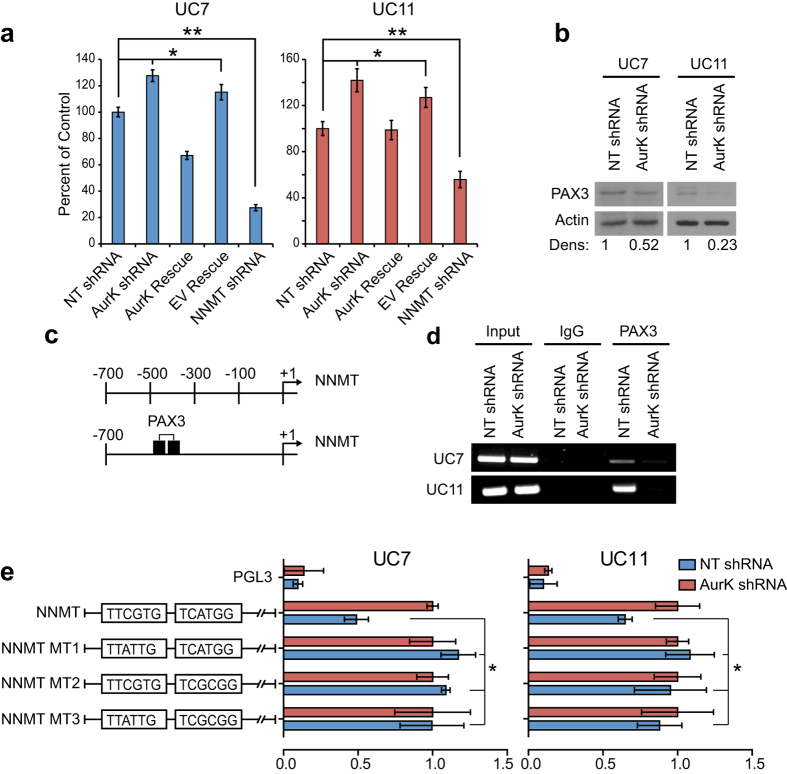
Transcriptional regulation of NNMT expression.(a) An NNMT activity assay was performed on UC7 and UC11 cell lines. The activity of NNMT normalized to actin correlated with its expression levels (*P < 0.05, **P < 0.01). (b) Western blotting revealed that expression levels of PAX3 decrease upon silencing of AURKA. Full length blots are shown in Supplementary Fig. S7. (c) Schematic presentation of the NNMT promoter. Two PAX3 binding sites are located within 500 bp upstream of the NNMT transcription start site. (d) Chromatin immunoprecipitation indicates that PAX3 binds to the NNMT promoter and represses its expression in both UC7 (top) and UC11 (bottom) cell lines. Full length gels are shown in Supplementary Fig. S7. (e) Luciferase based promoter analysis of the NNMT promoter with mutations in either of the PAX3 binding sites leads to an increase in luciferase expression in the non-targeted (NT) cells to similar levels as the AURKA KO cells. Mutation at both sites together did not have an additive effect, indicating that both sites are necessary for suppression of NNMT transcription (*P < 0.05).